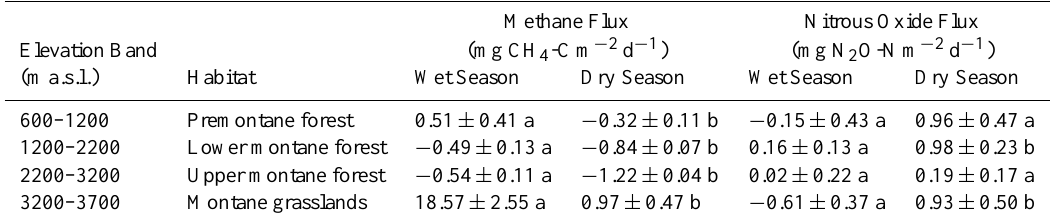
Table 4. Soil methane and nitrous oxide fluxes for each habitat for the wet and dry season. Lower case letters indicate differences among seasons within habitats (Fisher’s LSD, P < 0.05). Numbers reported here are means and standard